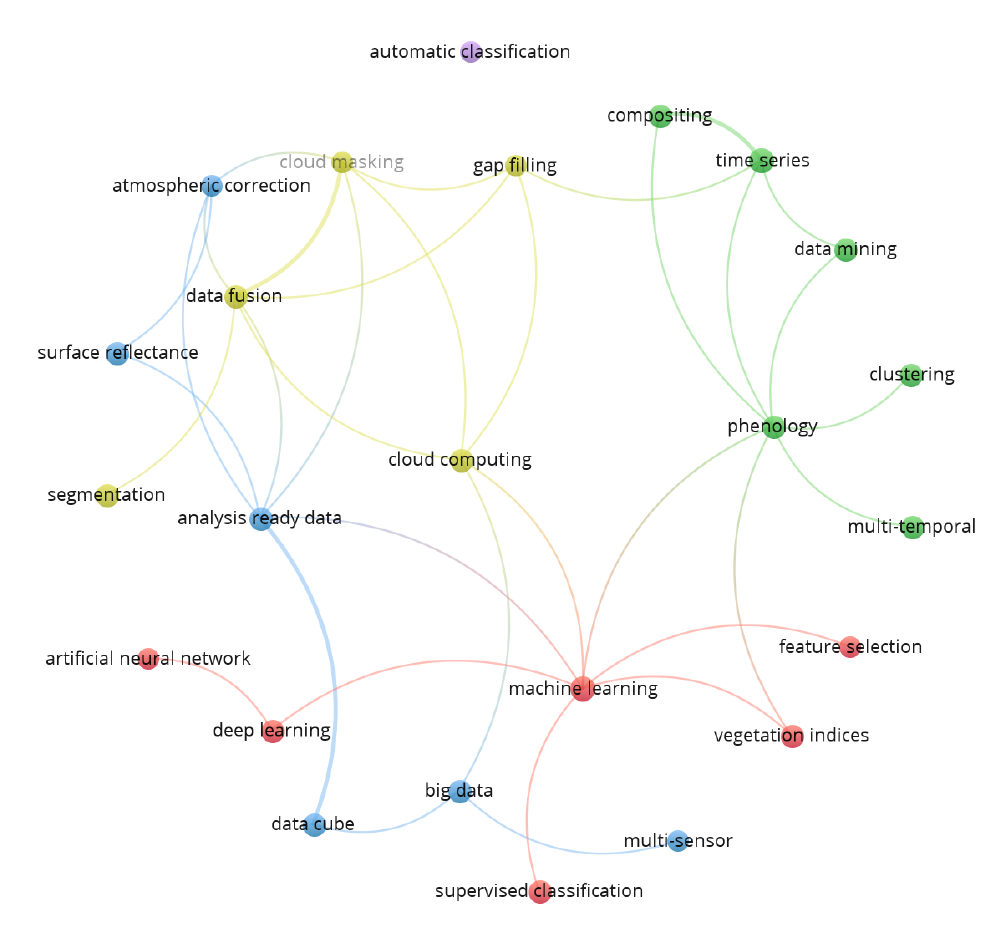
Figure 8. Scientific network mapping summarizing applications and approaches adopted with L8/OLI and S2/MSI data. Colors indicate the cluster in which each term was related the most. Lines represent co-occurrence link strength among